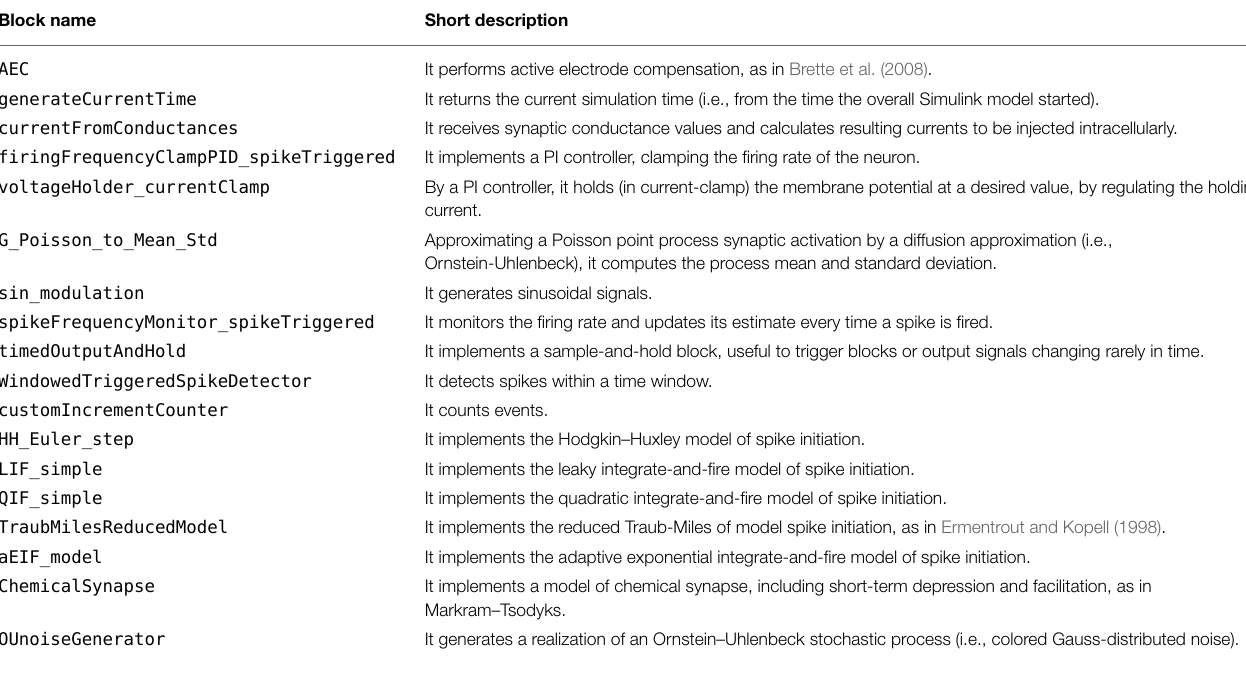
TABLE 1 | Blocks provided by our